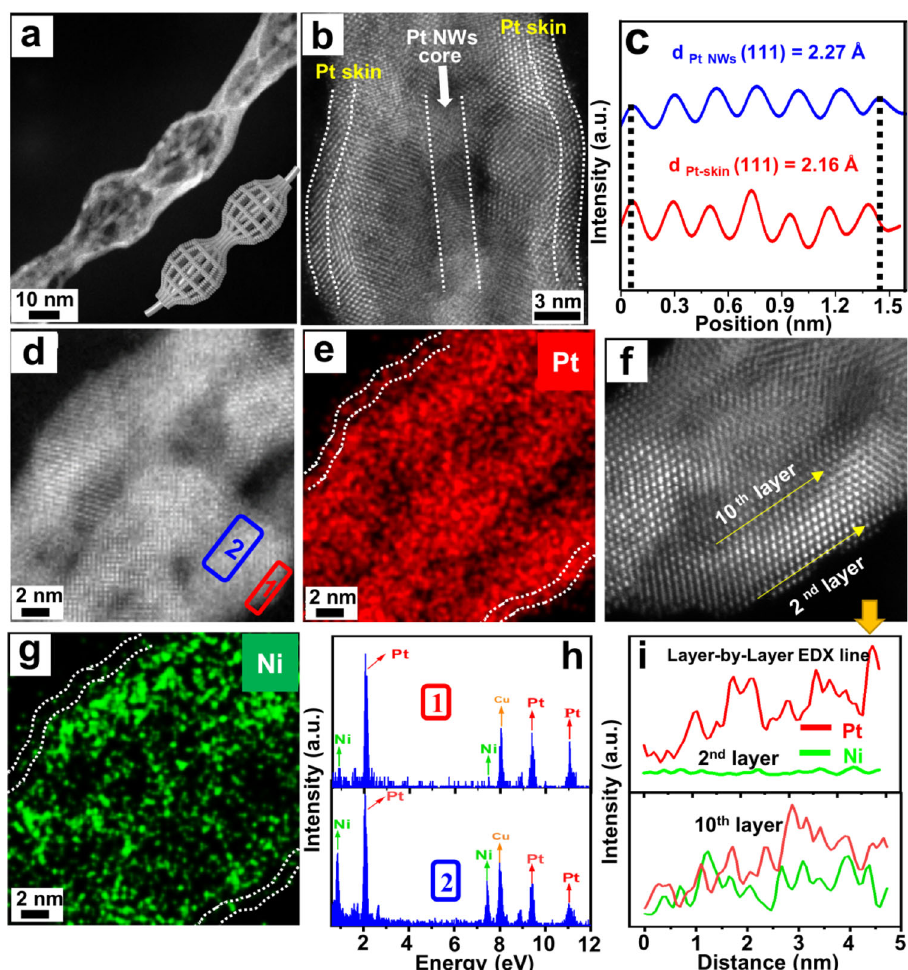
Fig. 3 | Structural and compositional characterizations of mesoporous Pt@Pt- skinPt 3 NiCSFWs.a , b , d , f HAADF-STEMandHRTEMimages. c Intensitypro fi lesof bulk Pt (111) and Pt-skin (111), which represents ~4.9% compressive strain of Pt-skin (111) compared to bulkPt(111). e , g STEM-EDX elementalmapping. h EDX intensity